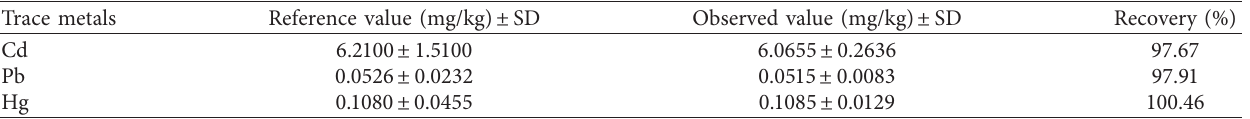
Table 2: Trace metals determination in proficiency tests (FAPAS canned fish samples).